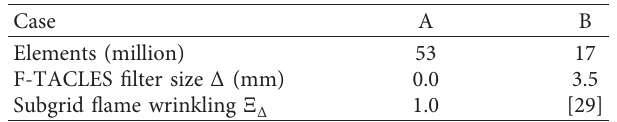
Figure 3: Instantaneous (a) and mean (b) OH-PLIF shots, from [19]. Table 1: Studied cases.